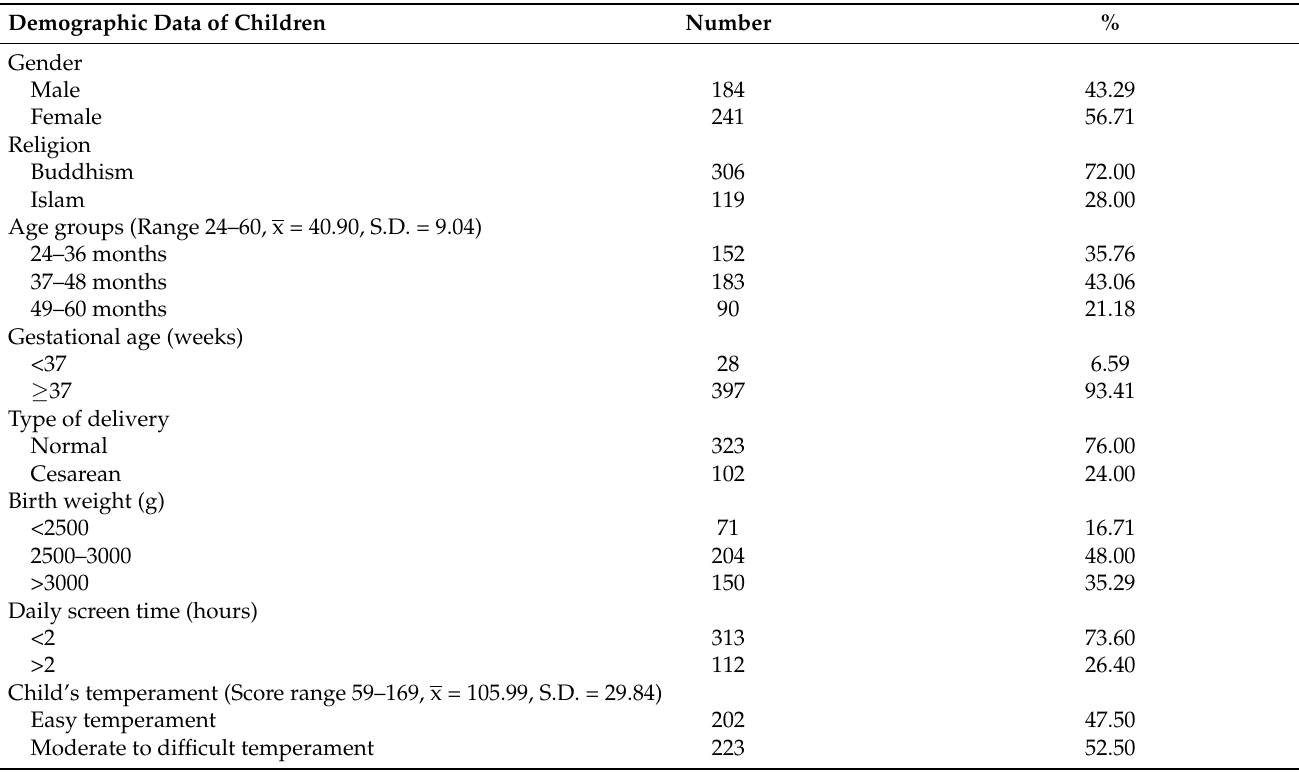
Table 2. The demographic data of children ( n =